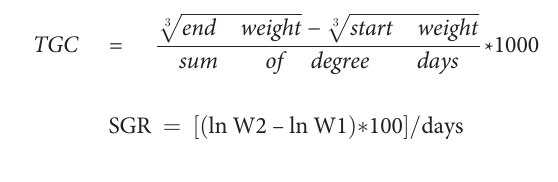
TABLE 2 | Description of sensors measuring water quality during S1 sampling. Water quality parameter